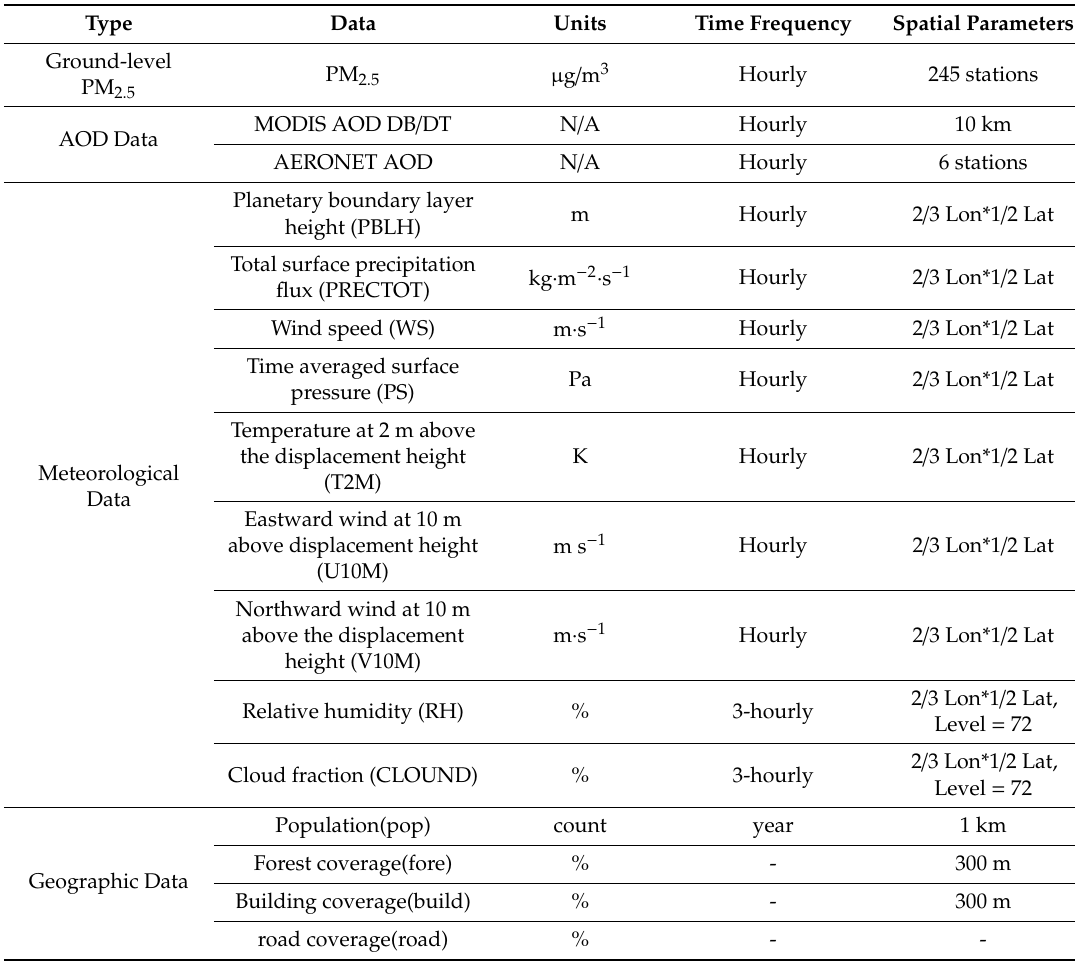
Table 1. The list of data in our